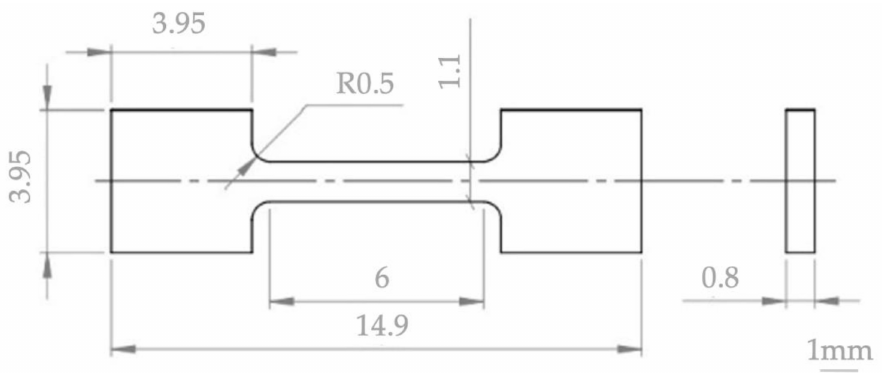
Figure 2. Geometry of sample for tensile